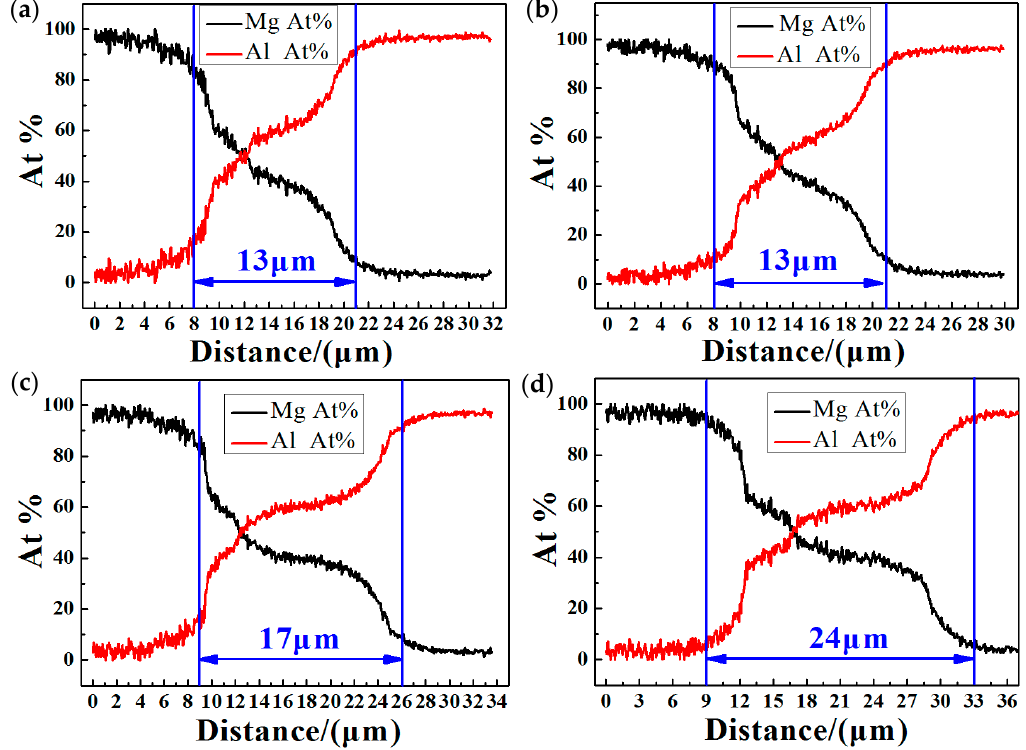
Figure 8. Line scan distribution of the annealed samples: ( a ) As-rolled; ( b ) 200 °C; ( c ) 300 °C; and ( d ) 350 °C.